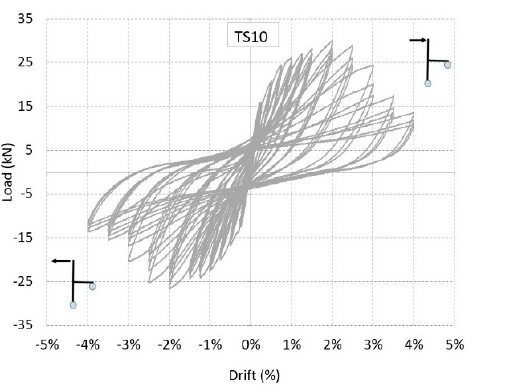
Figure 12. Load–drift envelopes of specimens TS2, TS9 and TS10.